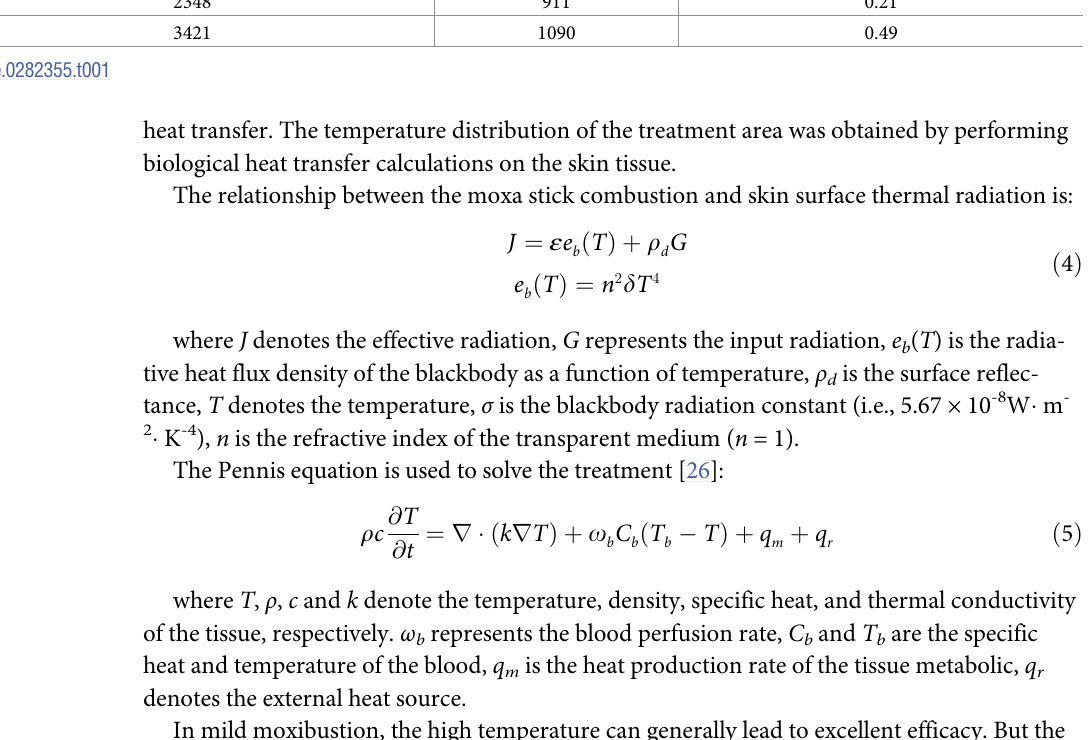
Table 1. The biological tissue characteristic parameters. Biological